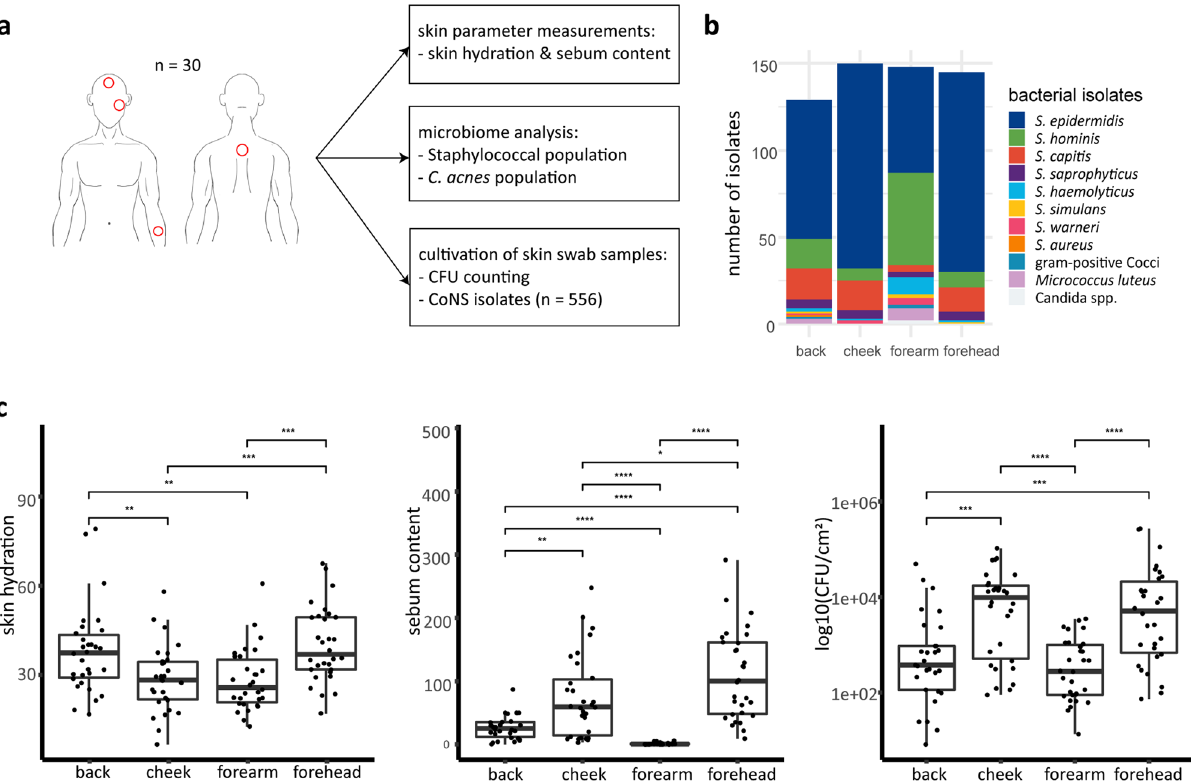
Fig. 1 Skin parameters and distribution of staphylococcal isolates on four different skin sites. a Study design. b Number of isolates of identi fi ed bacterial species per skin site. A selective cultivation approach to primarily isolate staphylococci was applied. c Skin hydration, sebum content and CFU per cm 2 on back, cheek, forearm, and forehead skin ( n = 30 for each skin site. * p ≤ 0.05, ** p ≤ 0.01, *** p ≤ 0.001, **** p ≤ 0.0001. Unpaired Wilcoxon test). Middle lines of boxplots indicate the median. Lower and upper lines represent the fi rst and third quartiles. Whiskers show the 1.5x inter-quartile